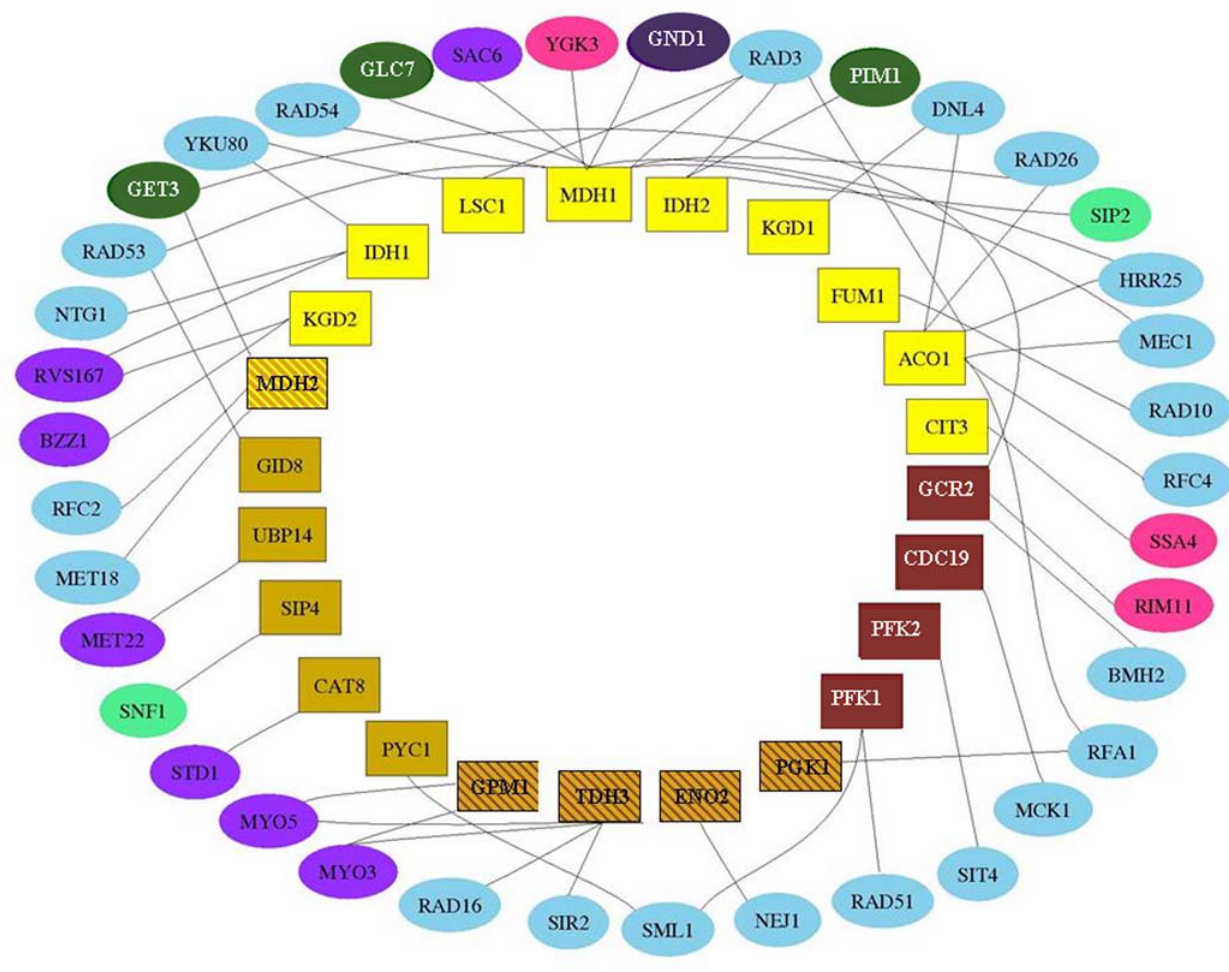
Figure 1. Proteins that participate in ‘‘main pathways of carbohydrate metabolism’’ (rectangular nodes) and interact with proteins that participate in ‘‘response to stress’’ (elliptic nodes). The colors of the nodes represent the sub-term annotation: rectangular nodes correspond to: ‘‘tricarboxylic acid cycle intermediate metabolism’’ (yellow), ‘‘gluconeogenesis’’ (orange) and ‘‘glycolysis’’ (dark brown). Elliptic nodes correspond to ‘‘response to-’’: ‘‘DNA damage stimulus’’ (bright blue), ‘‘osmotic stress’’ (dark purple), ‘‘heat’’ (dark green), ‘‘starvation’’ (bright green), ‘‘oxidative stress’’ (dark blue). 3 genes are not annotated to any process more specific than ‘‘response to stress’ (pink). A total of 62 proteins are annotated with ‘‘main pathways of carbohydrate metabolism’’, and interact with 190 proteins that are not annotated with ‘‘main pathways of carbohydrate metabolism’’. Of the latter, 38 are annotated with ‘‘response to stress’’. The total number of proteins annotated with ‘‘response to stress’’ is 337. Consequently, the PPI-link between the two processes is predicted (p-value: 1.47e 2 5 ). algorithm integrates PPI-linked processes into the prediction by